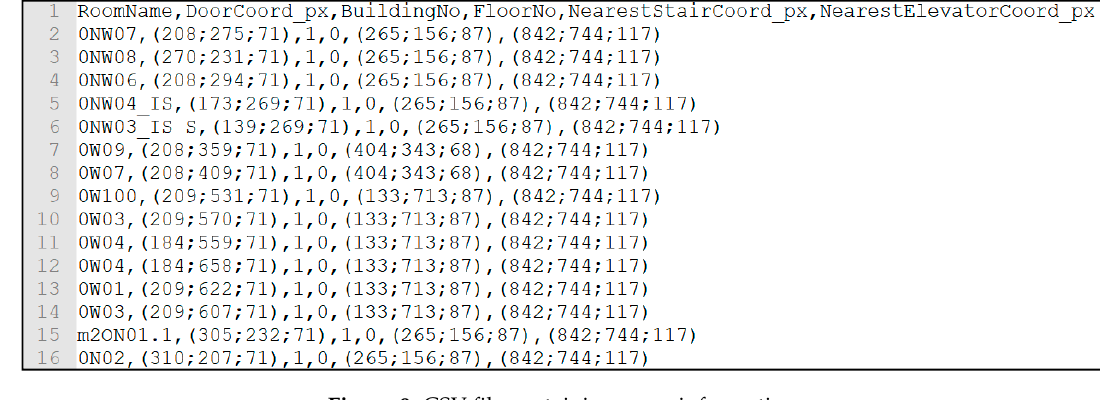
Figure 9. CSV file containing room information.